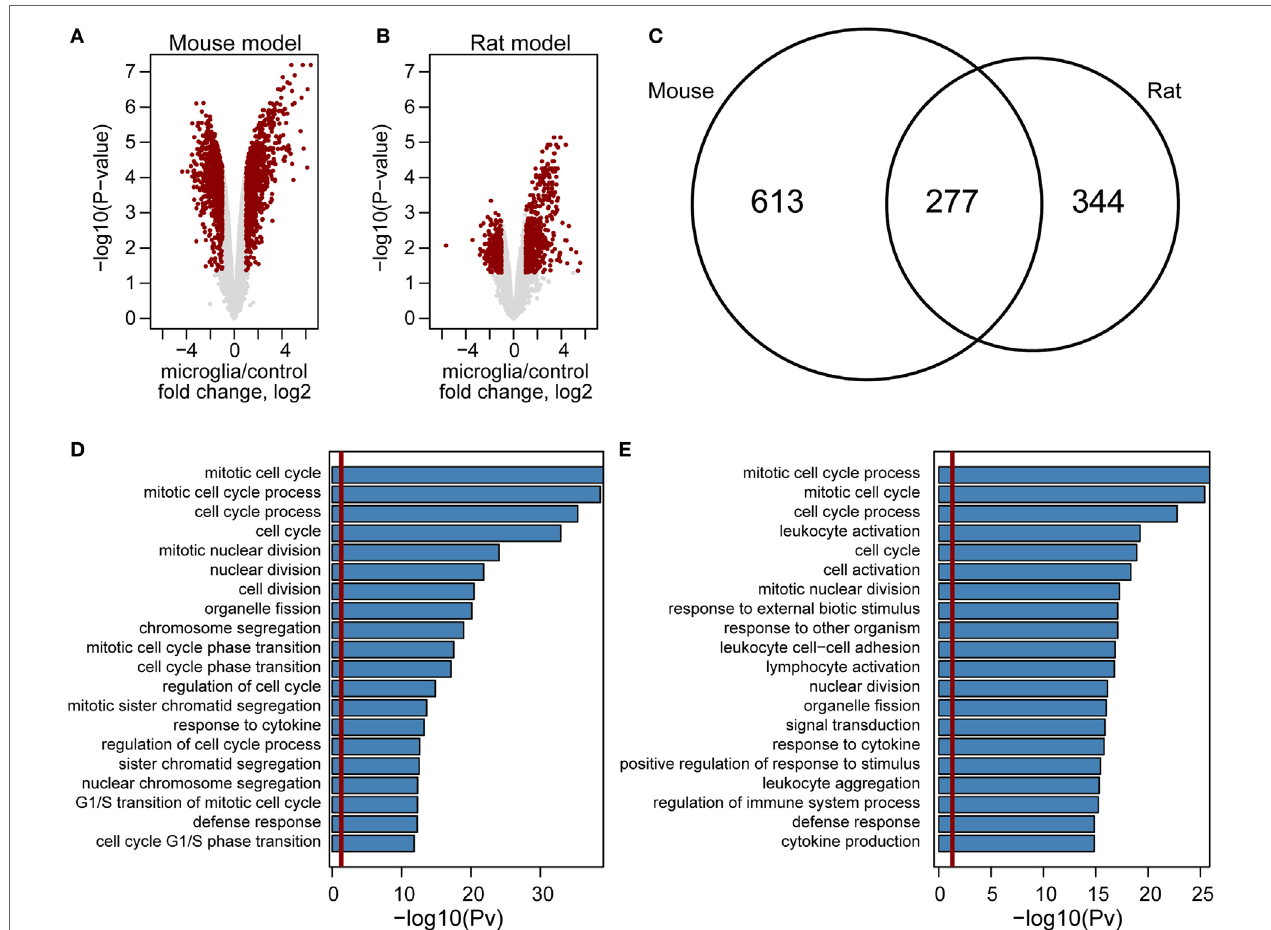
FigUre 5 | Genome-wide comparison of gene expression in microglia in mouse and rat glioma models. Volcano plot of gene expression changes in glioma- associated microglia/macrophages from mouse (a) and rat (B) models. The data for all genes are plotted as log2 fold change between microglia and control samples versus the − log10 of the corresponding adjusted p -values. Genes selected as significantly different are highlighted as red dots. Venn diagram for overlap of genes upregulated in mouse (left) and rat (right) model (c) . Enrichment analysis of Gene Ontology terms within mouse (D) and rat (e) upregulated genes. Bar plots represent the statistical significance of the enrichment [ − log10 ( p -val)] (D,e)